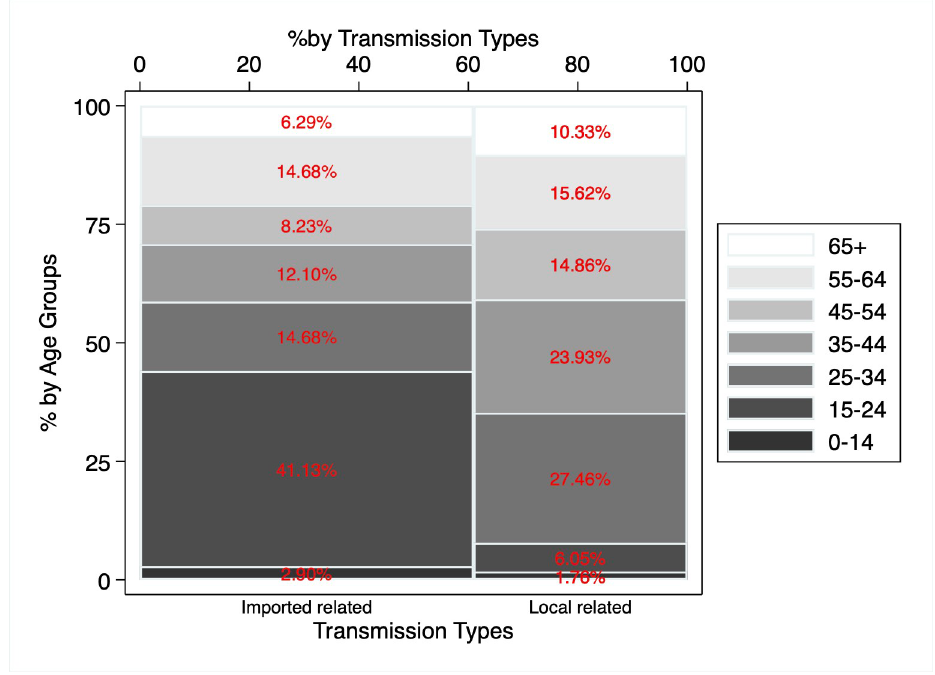
Fig 2. Distribution of confirmed COVID-19 cases by transmission type and by age groups: Hong Kong (n = 1,017, as of April 16, 2020). Data Source: Hong Kong Centre for Health Protection, Department of Health.